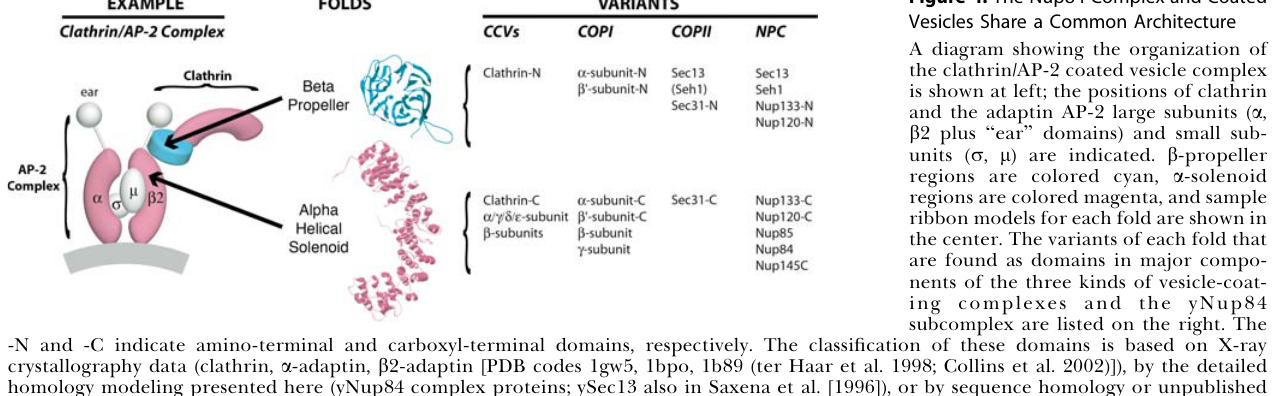
Figure 4. The Nup84 Complex and Coated Vesicles Share a Common Architecture A diagram showing the organization of the clathrin/AP-2 coated vesicle complex is shown at left; the positions of clathrin and the adaptin AP-2 large subunits ( a , b 2 plus ‘‘ ear ’’ domains) and small sub- units ( r , l ) are indicated. b -propeller regions are colored cyan, a -solenoid regions are colored magenta, and sample ribbon models for each fold are shown in the center. The variants of each fold that are found as domains in major compo- nents of the three kinds of vesicle-coat- ing complexes and the yNup84 subcomplex are listed on the right. The